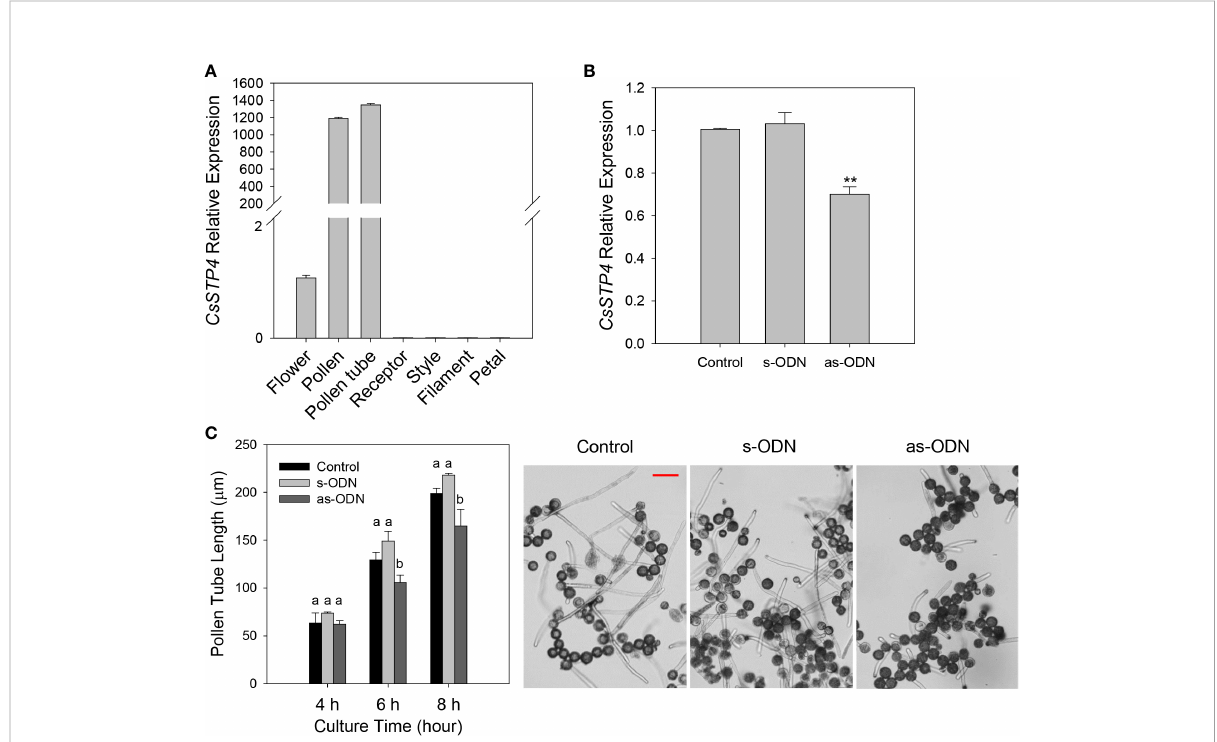
FIGURE 7 The pollen tube growth was inhibited with the lower expression of CgSTP4 . (A) The expression of CgSTP4 in different tissues of fl ower was determined by qRT-PCR. The CgActin was de fi ned as the reference and the CgSTP4 ’ s expression level in fl ower tissue was normalized as 1. (B) Expression levels of CgSTP4 in pollen tubes transfected with antisense or sense oligonucleotide of CgSTP4 (s-CgSTP4, as-CgSTP4), or transfection agent alone (Control). The CgActin was de fi ned as the reference and the CgSTP4 ’ s expression level in control condition was normalized as 1. Data are mean ± SE (n=3). * Represents signi fi cant difference in comparison with control using Student ’ s t test at p < 0.05. (C) Pollen tube growth assay after transfection with as-CgSTP4, s-CgSTP4, or transfection agent alone (Control). Scale bar = 50 m m. Data are mean ± SE (n=3). Letters (A – B) indicate signi fi cant differences at each sampling point ( p < 0.05) using Duncan ’ s multiple range test (MRT) after